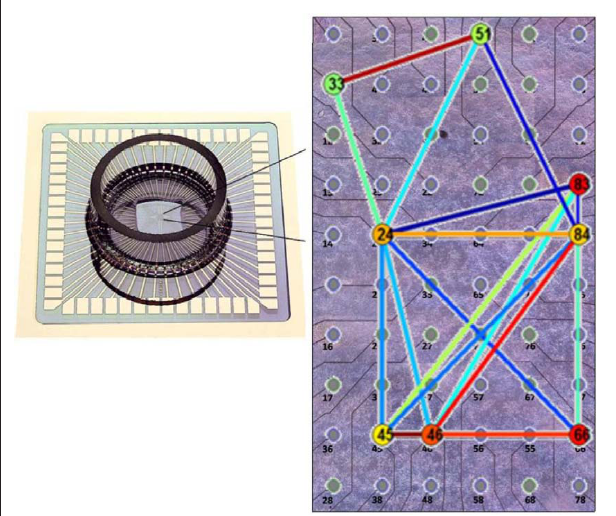
Figure 1 | experimental setup for multicellular recording. On the left, a Micro-Electrode Array chamber for recording dissociated primary neural cell cultures. On the right, a magnified image of the planar recording surface. Thin lines represent traces which terminate at circular electrode pads capable of recording the membrane potential changes of nearby neurons. The colored lines, as in the real space diagrams of represent phase synchronization links between neurons adjacent to their respective electrodes. The colored circles overlaying the electrodes represent the centrality of the electrode. (Photos by MultiChannel Systems, Reutlingen, Germany, overlay by